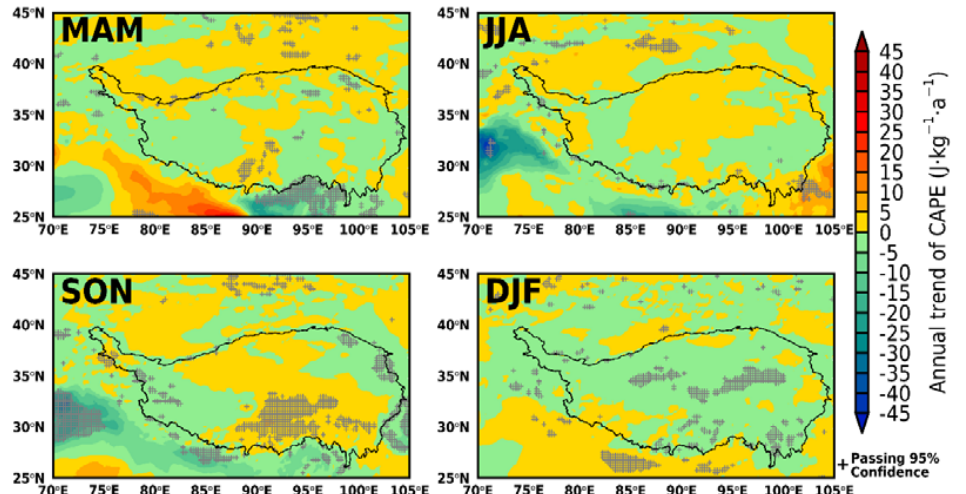
Figure 7. Similar to Figure 6, but for the annual trend of wind speed.